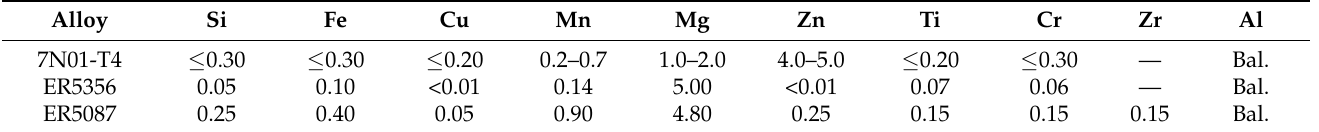
Table 1. Chemical compositions of 7N01-T4 aluminum alloy and the welding wires (wt. %).